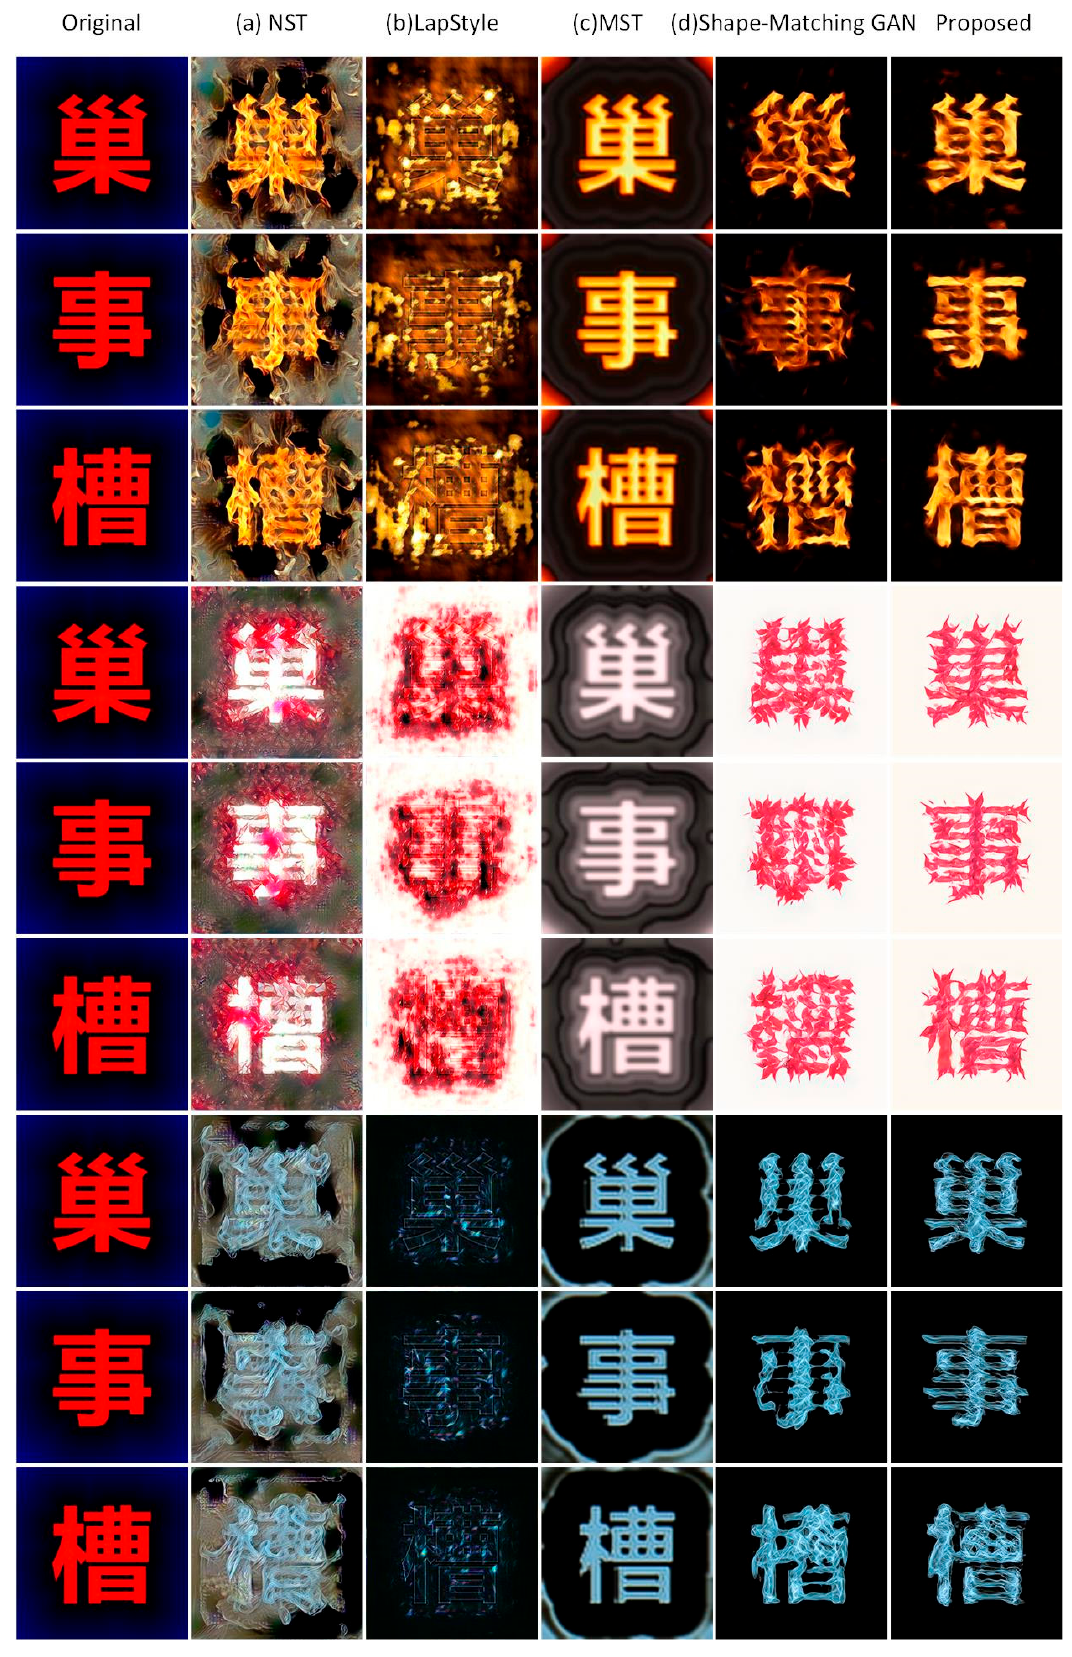
Figure 5. Comparison with state ‐ of ‐ the ‐ art methods on various styles.